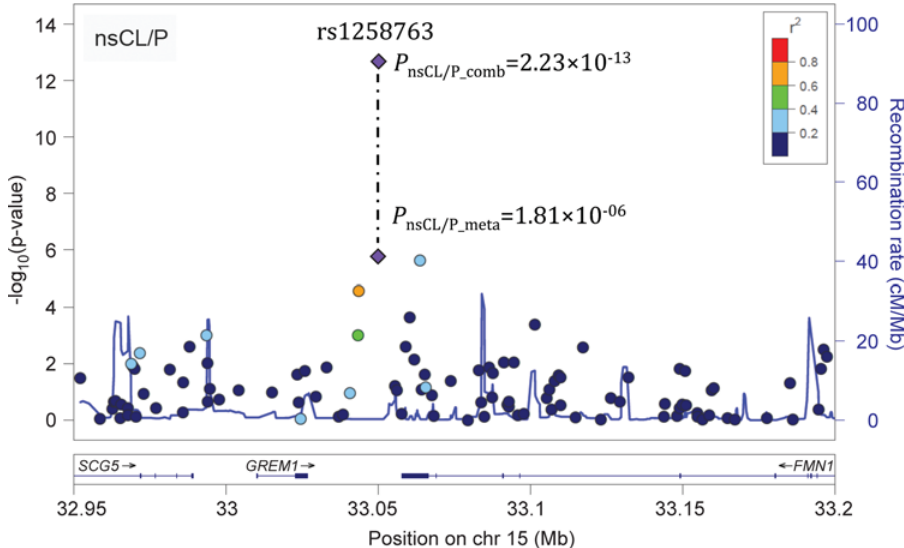
Fig 1. Regional association plot for the 15q13 region. P -values for SNPs at 15q13 that were analyzed as part of the Ludwig 2012 meta-analysis ( P nsCL/P_meta ) are plotted against their chromosomal position (hg19). Full data are provided in S1 Dataset. For each variant, color code denotes linkage disequilibrium to rs1258763, based on 1000genomes. After combination with data from replication I and II, the top variant rs1258763 (purple diamond; indicated by dotted line) reaches genome-wide significance. Plot was generated using LocusZoom [28].